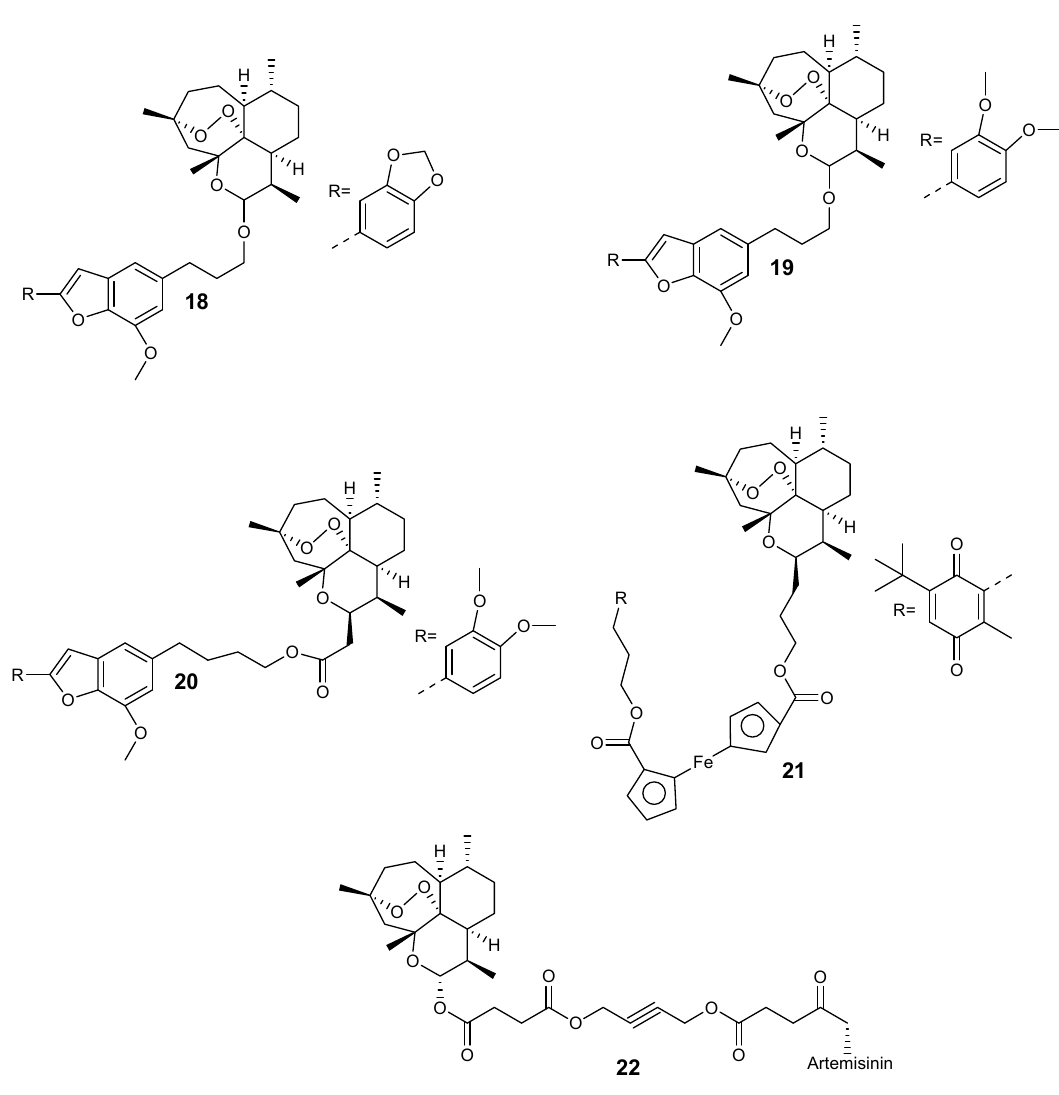
Molecules 2019 , 24 , x Figure 6. Artemisinin-based hybrid compounds. Figure 6. Artemisinin-based hybrid compounds.